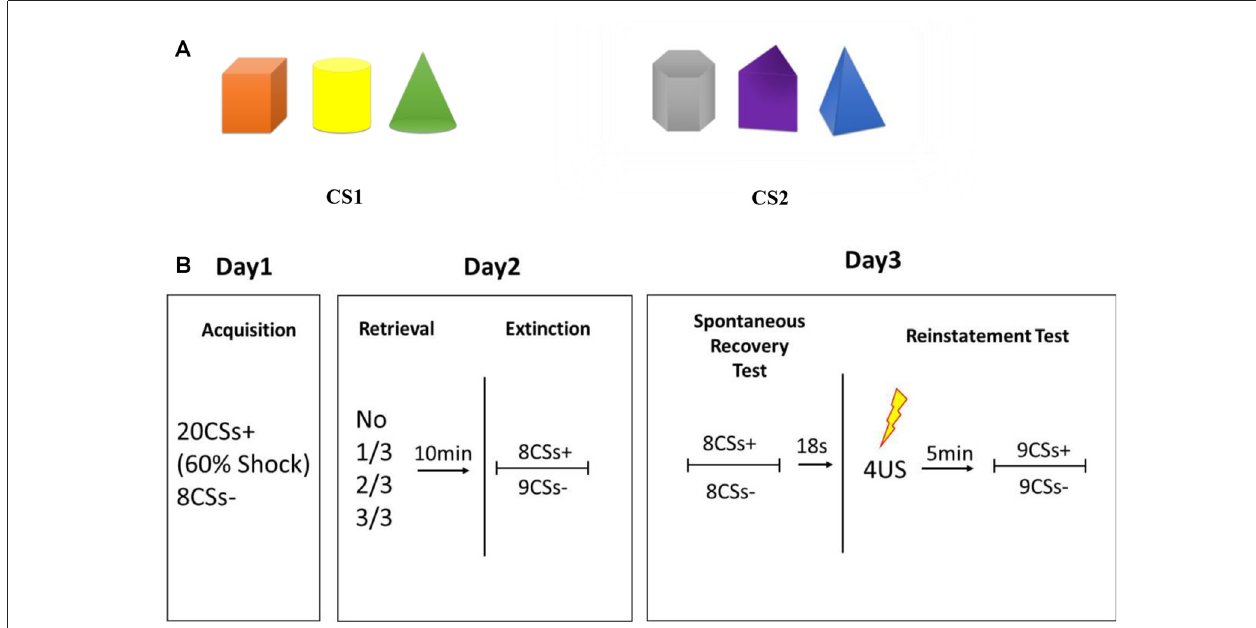
FIGURE 1 | (A) Conditioned stimulus (CS). (B) Schematic representation of the experimental design. During acquisition, 20 trials of CS were presented to participants with a reinforcement ratio of 60%, which were: 12 CS+ accompanied by an electric shock; 8 CS+ without an electric shock; 8 CS − without an electric shock. During extinction, 8 CS+ and 9 CS − were presented, all with no shock. The first CS − trial in each phase was disregarded due to the orientation response at the beginning of the